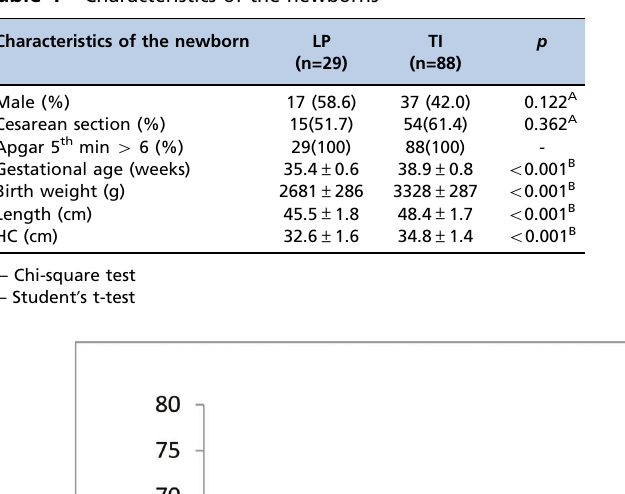
Table 1 - Characteristics of the newborns